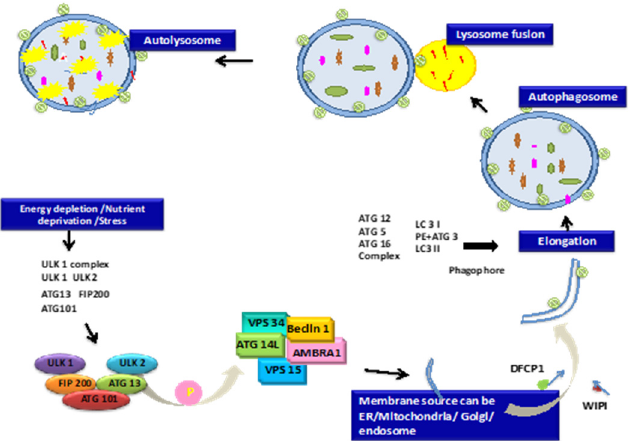
Figure 3. Molecular pathways involved in autophagy as explained thoroughly in the text above. Briefly, energy depletion leads to the activation of autophagy pathways by inducing LC3 signaling pathways. This leads to the formation of autophagosomes, which fuse into the lysosome forming autolysosomes.